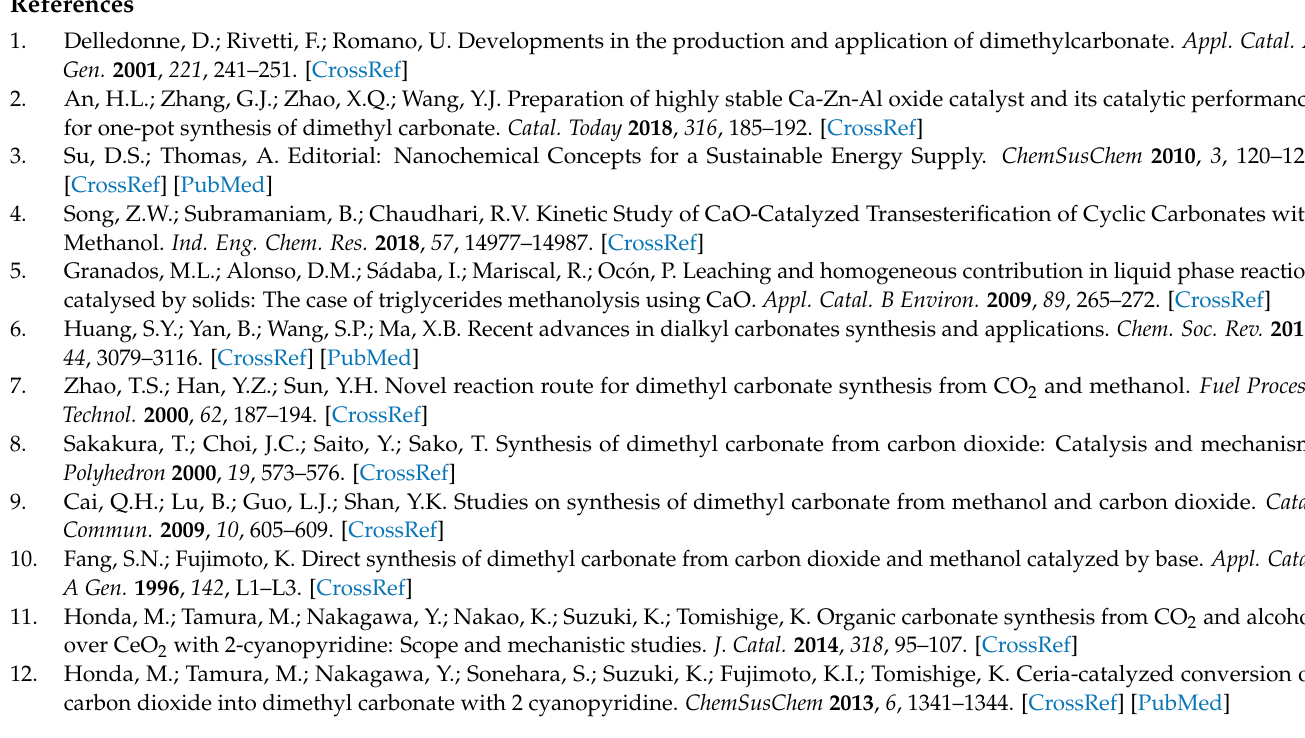
Figure S2: In situ FTIR spectra of CH 3 OH adsorption on the Zr-SBA-15 catalyst; Figure S3: In situ FTIR spectra of CO 2 adsorption on Zr-SBA-15 pre-adsorbed CH 3 OH; Figure S4: In situ FTIR spectra of CO 2 adsorption on the Zr/SBA-15 catalyst; Figure S5: In situ FTIR spectra of CH 3 OH adsorption on Zr/SBA-15 pre-adsorbed CO 2 ; Figure S6: In situ FTIR spectra of CO 2 adsorption on the Zr-SBA-15 catalyst; Figure S7: In situ FTIR spectra of CH 3 OH adsorption on Zr-SBA-15 pre-adsorbed CO